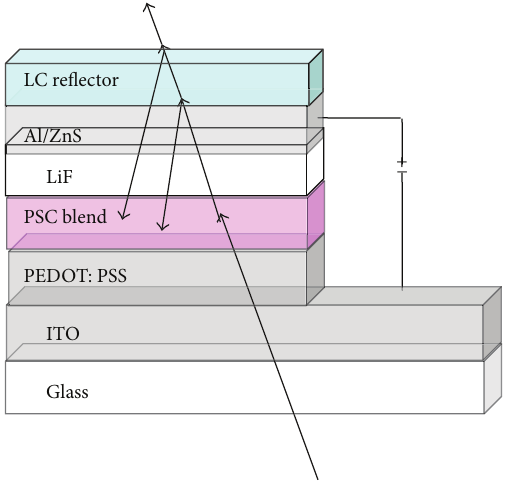
Figure3:SchematicrepresentationofthesemitransparentPSCwith an LC reflector. Table 2: Performance parameters for the semitransparent